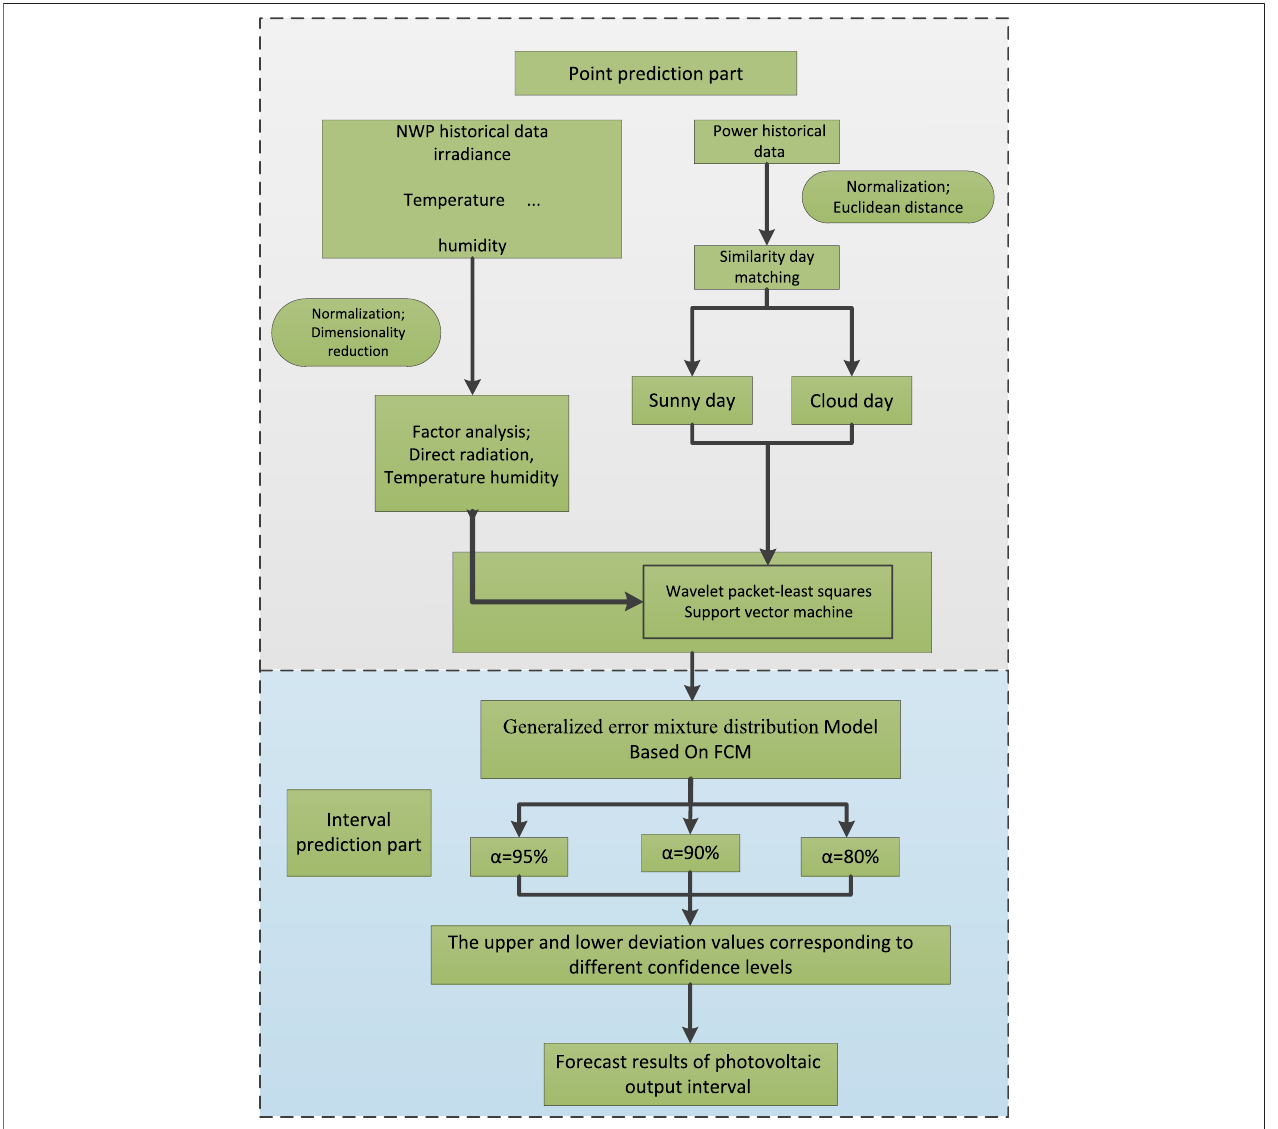
FIGURE 4 | Flow chart of short-term PV power generation probability interval prediction based on mixture of WP-LSSVM and the improved generalized error distribution.